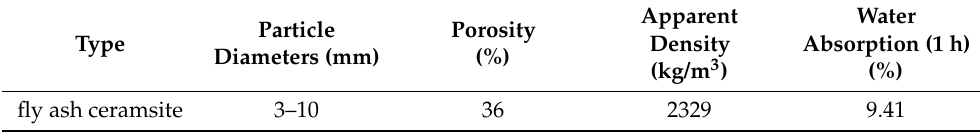
Table 5. The properties of ceramsite